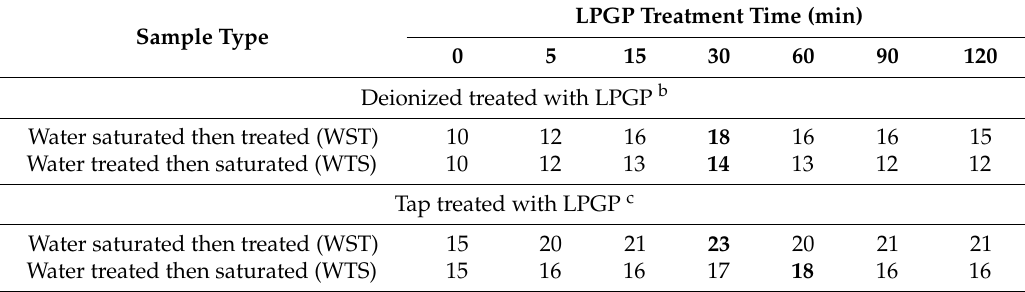
Table 4. Molecular oxygen content (mg / L) a of water treated under oxygen with